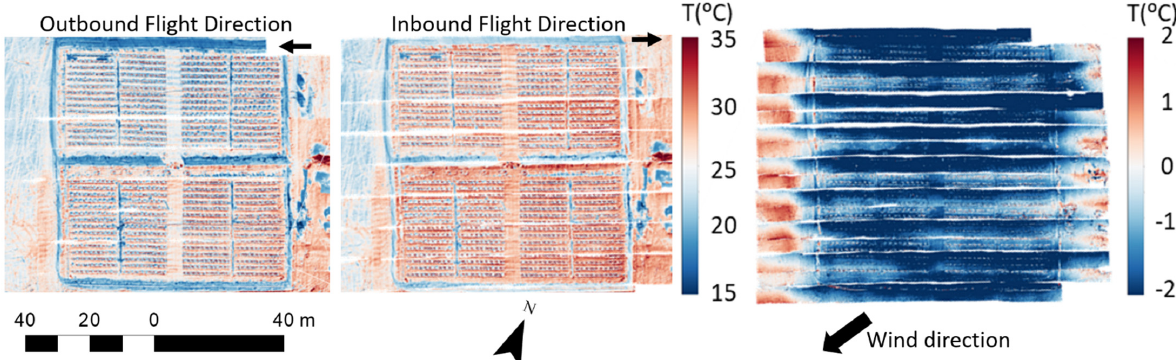
Figure 7. Orthomosaic using outbound (flight orientation of 66° north) orthophotos ( left ), orthomosaic using inbound (flight orientation of 246° north) orthophotos ( middle ) and the difference between inbound and outbound orthophotos ( right ) on 7 January 2018 at 09:16. The wind orientation was 31° north (±5°), and the average wind speed was 3.6 m/s for this flight survey.